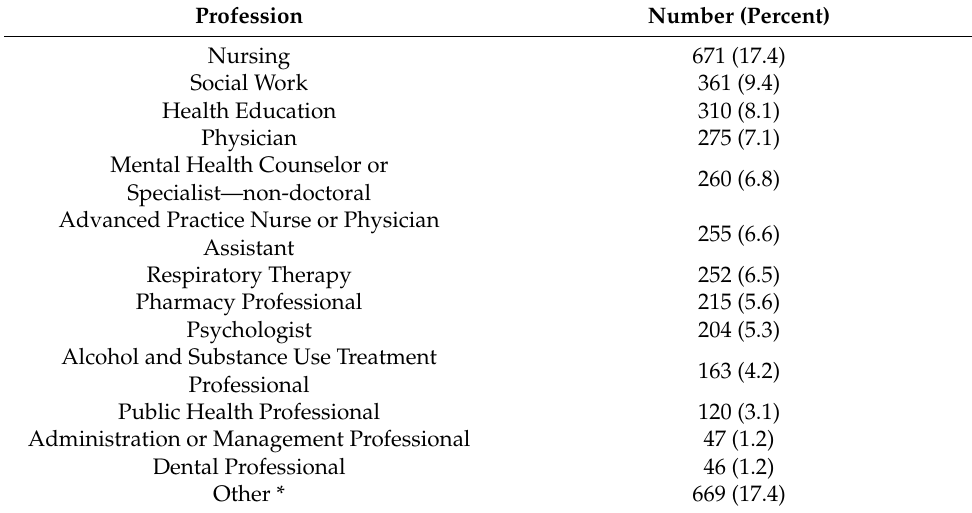
Table 4. Primary professional background of trainees ( n = 3848).